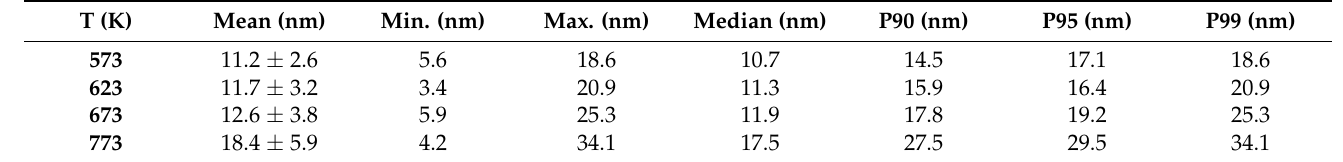
Table 2. Results of the particle size distribution analysis based on TEM